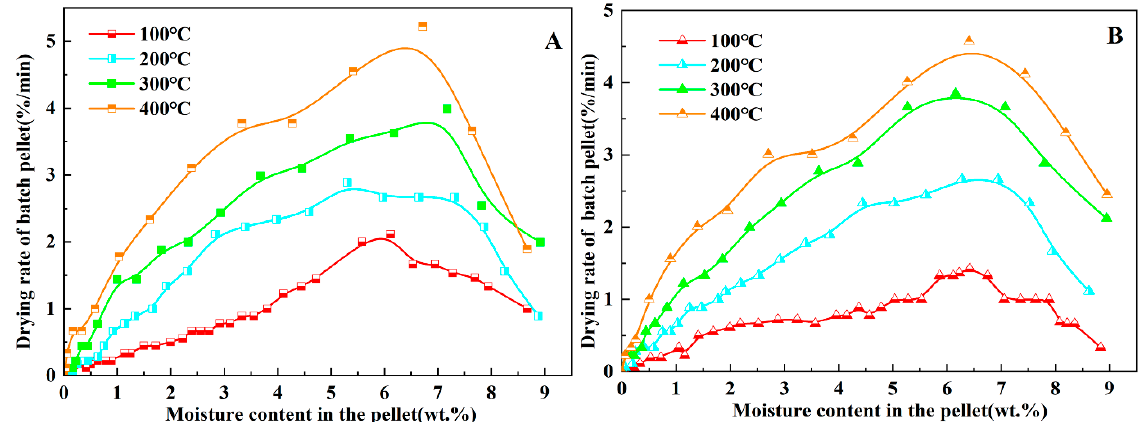
Figure 3. Drying characteristic curves of ( A ) MHA and ( B ) HAMB at different wind temperatures.